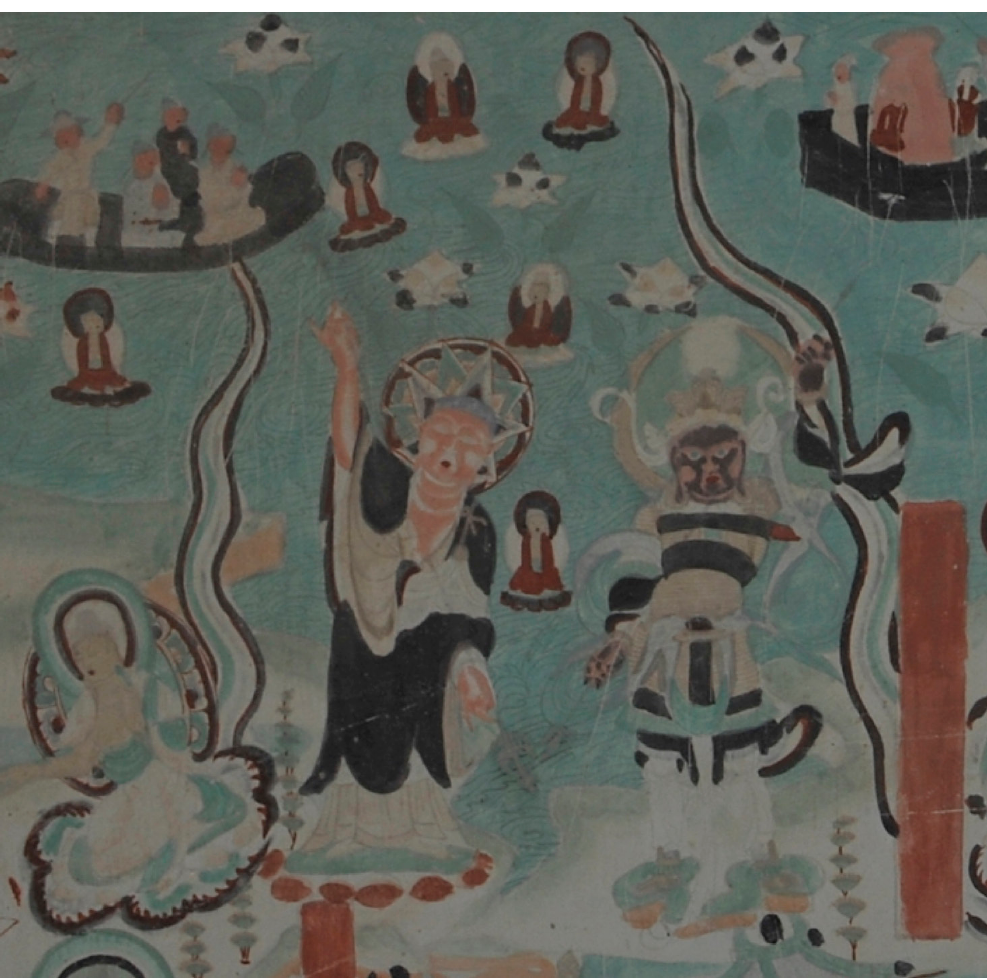
Detail of the Oxhead Mountain tableau in Cave YL 33, reproduced with the permission of the Dūnhuáng